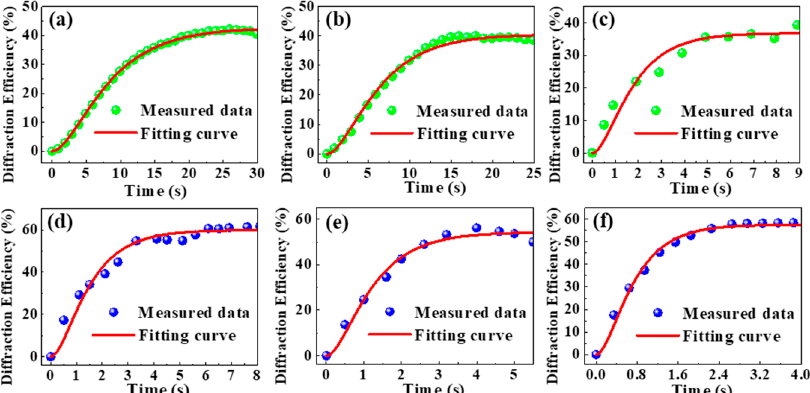
Figure 1. Evolution of di ff raction e ffi ciency with time for LN:V,Zr,Fe crystals: ( a ) LN1, ( b ) LN2, and ( c ) LN3 at 532 nm, respectively, and ( d ) LN1, ( e ) LN2, and ( f ) LN3 at 488 nm, respectively.